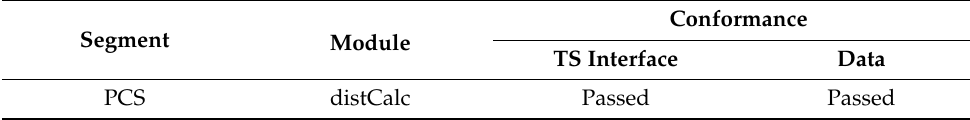
Table 9. The test result of distCalc module on the FACE CTS. Table 8. A specification of distCalc and sample data.